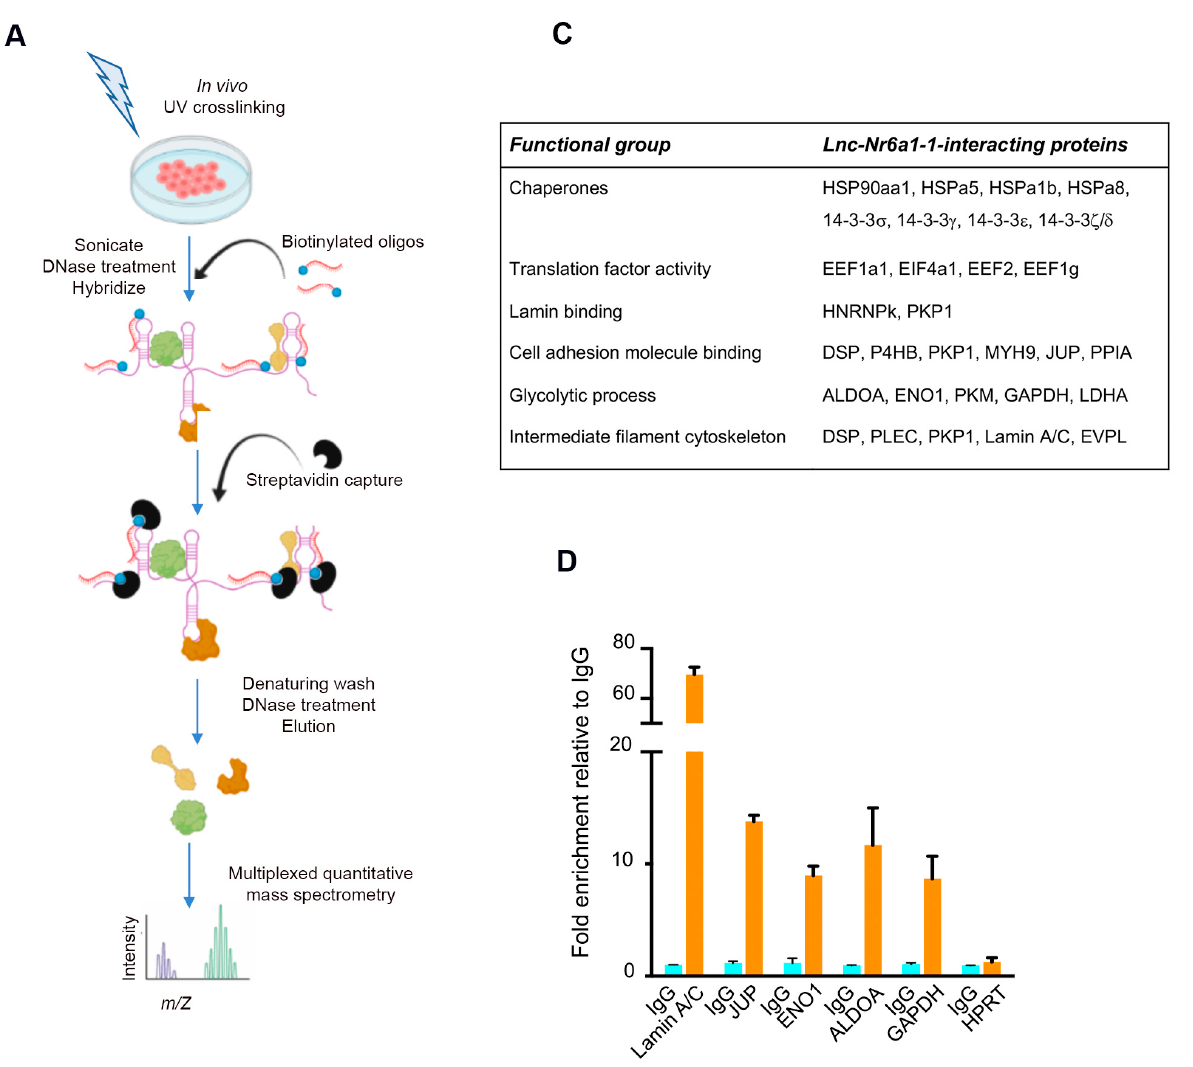
Figure 7. iDRIP-MS reveals direct lnc- Nr6a1-1 -interacting proteins. ( A ) A schematic overview of the iDRIP-MS method. ( B ) Retrieval of RNA by iDRIP using lnc- Nr6a1-1 and LacZ probes measured by RT-qPCR. Efficiency of lnc- Nr6a1-1 pulldown was determined by comparing to a standard curve generated using serial dilutions of input. Error bars S.D. ( C ) Selected lnc- Nr6a1-1 -interacting pro- teins identified by iDRIP are grouped into functional classes. ( D ) Physical association of lnc- Nr6a1- 1 with Lamin A/C, g-catenin (Plakoglobin), ENO1, ALDOA and GAPDH was confirmed by RNA immunoprecipitation (RIP). ENO1, enolase; ALDOA, aldolase; GAPDH, glyceraldehyde 3-